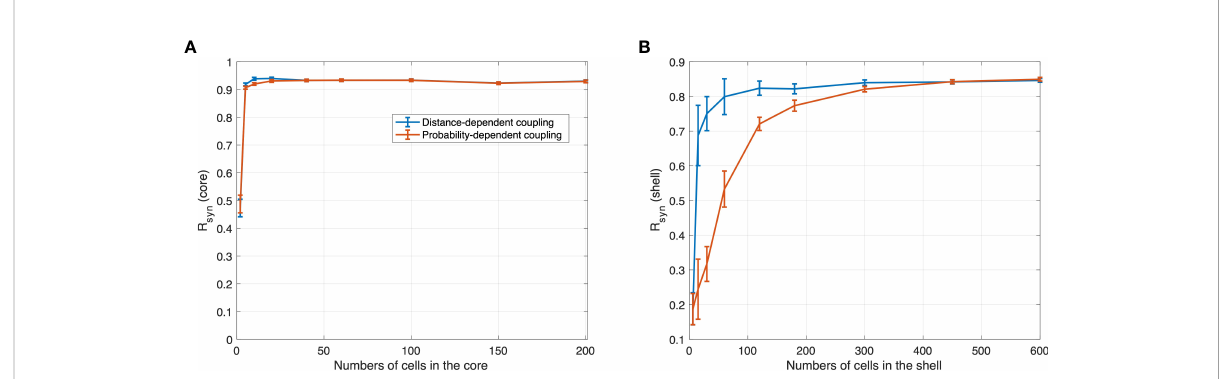
FIGURE 3 R synchronization values obtained with different numbers of cells in (A) core and (B) shell under 12 h light 12 h dark for the distance-dependent network and probability-dependent network computed with normalized distance threshold D PT D mean R syn and its standard deviations were computed from the 50 network realizations. The synchronization level in the core increases abruptly as the number of cells increases. Compared to the core, the synchronization level in the shell increases gradually, with the distance-dependent coupling network being more sensitive to the population